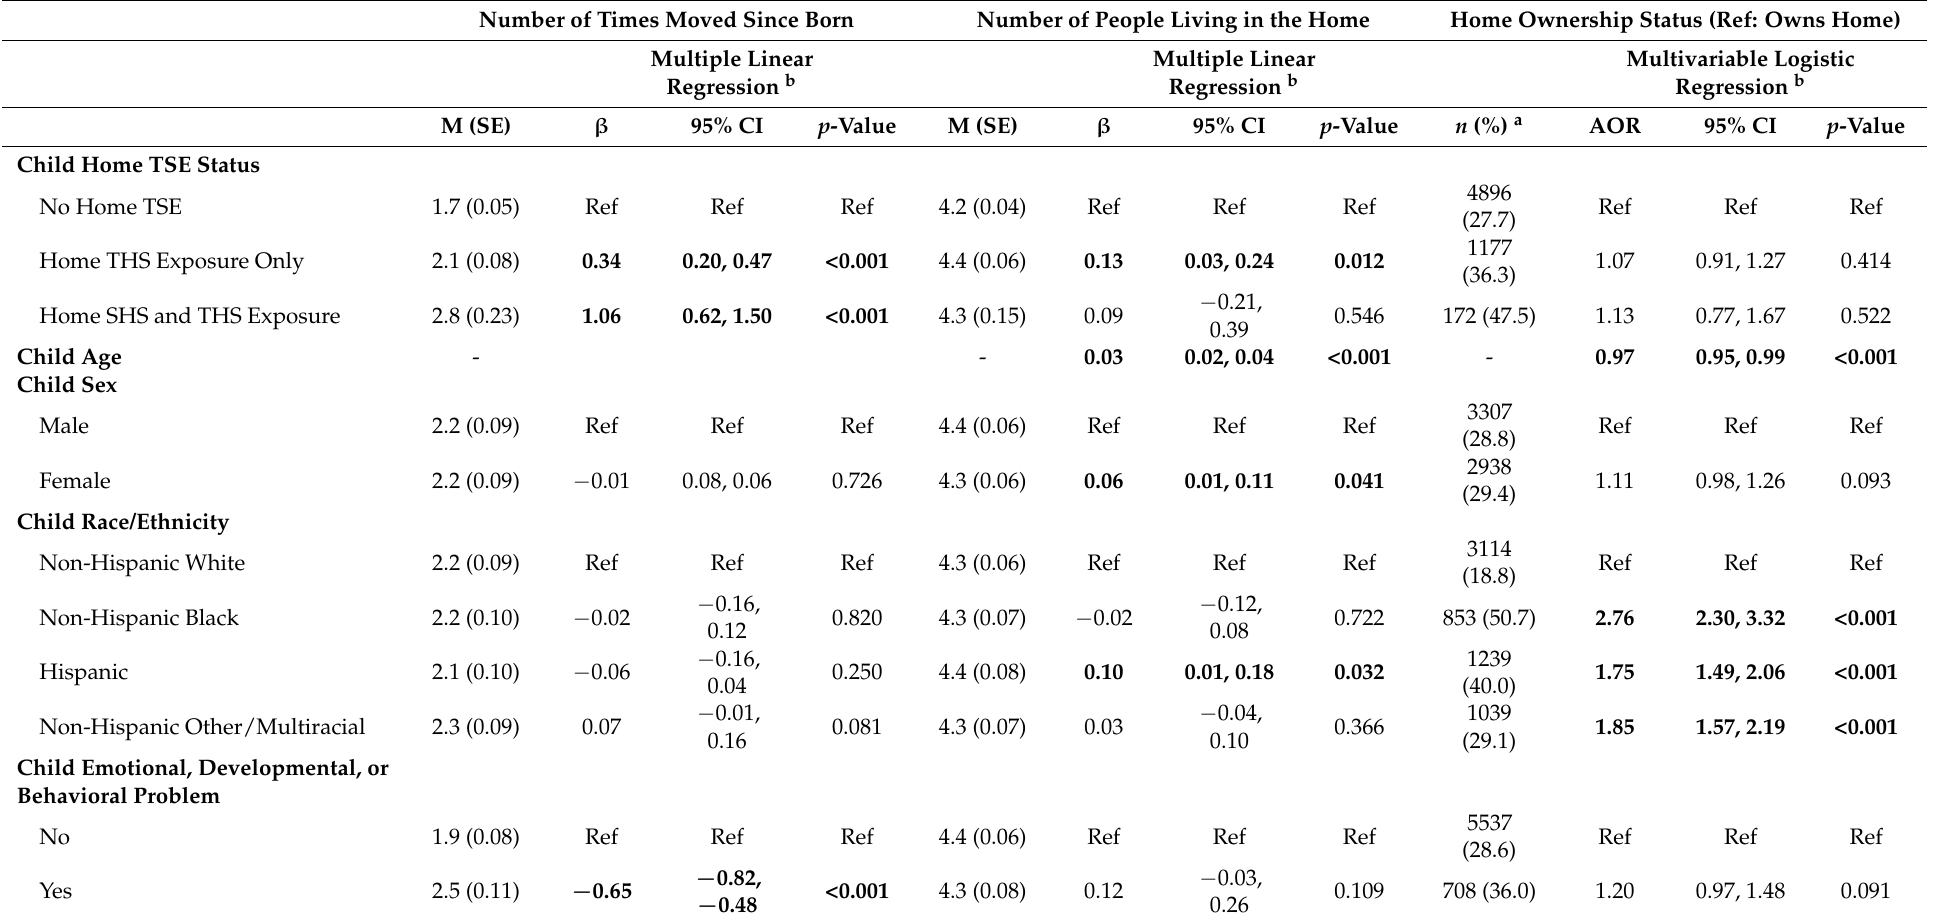
Table 3. Child Home TSE Status and Household Characteristics among U.S. Children Ages 0–11 Years, 2018–2019